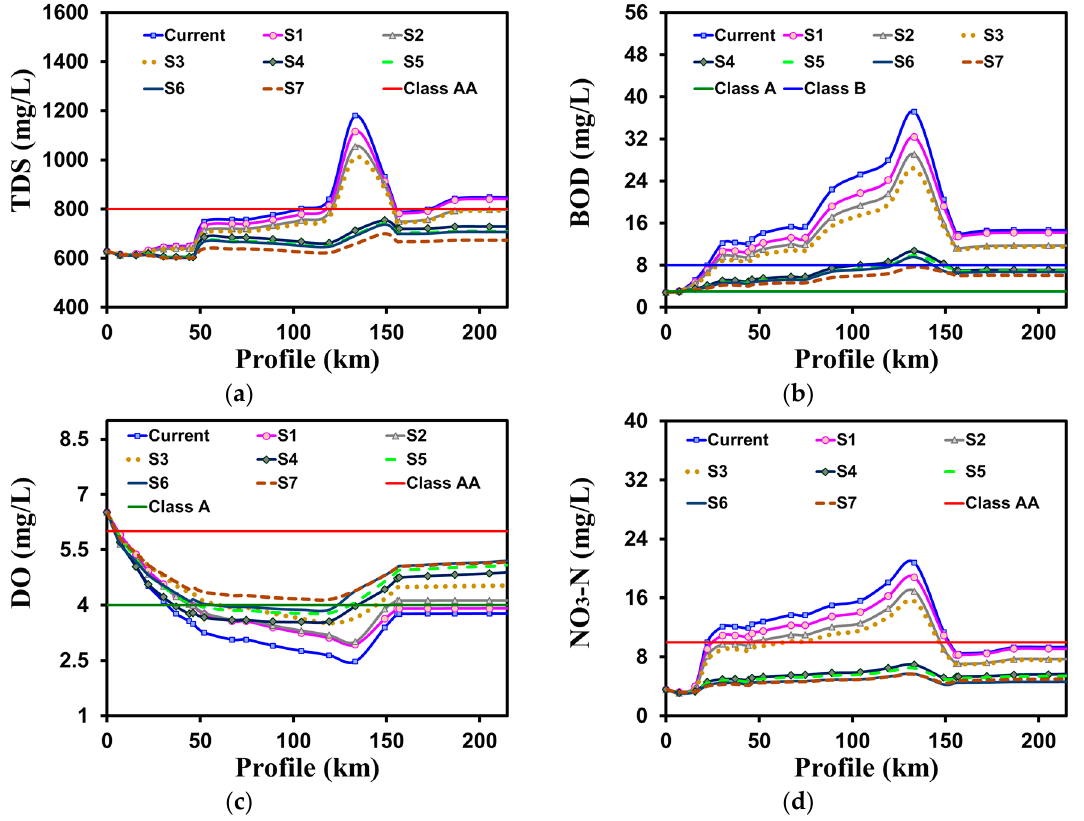
Figure 9. Comparison of scenario ‐ based water ‐ quality management results with current conditions along the Ravi River. ( a ) TDS, ( b ) BOD, ( c ) DO, and ( d ) NO 3 ‐ N.